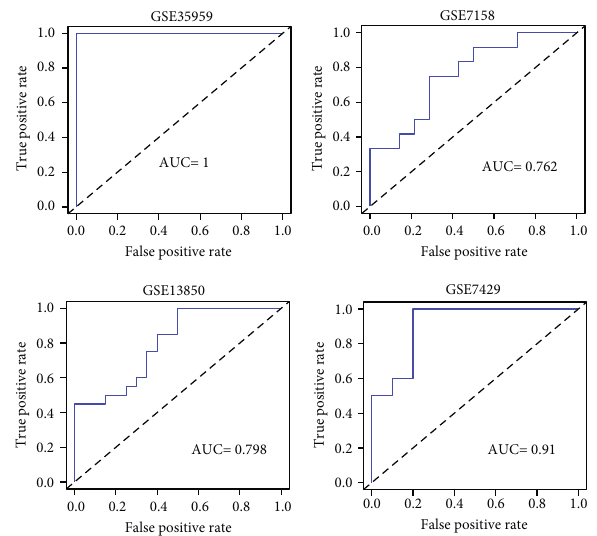
Figure 4: Construction of 7 key gene diagnostic